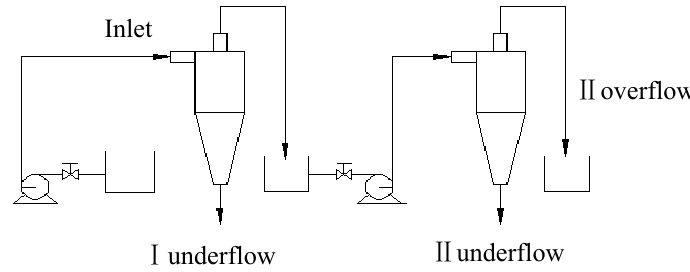
Figure 2. Classification diagram of the three product cycolone.